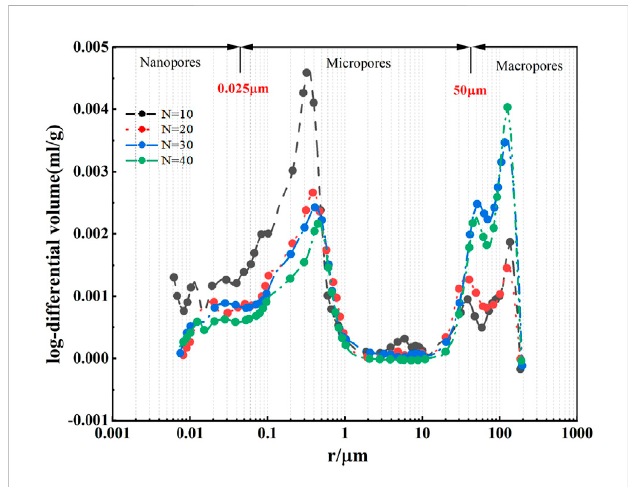
FIGURE 6 Mercury injection volume increment of each pore radius after different freeze-thaw